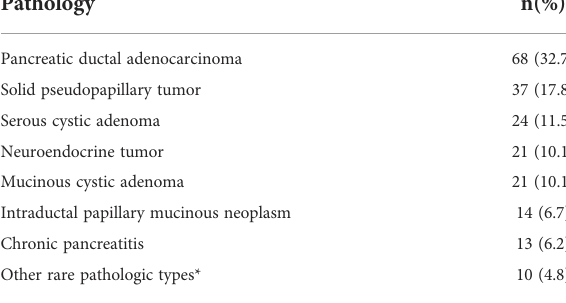
TABLE 1 Pathological array of 208 distal pancreatectomies.